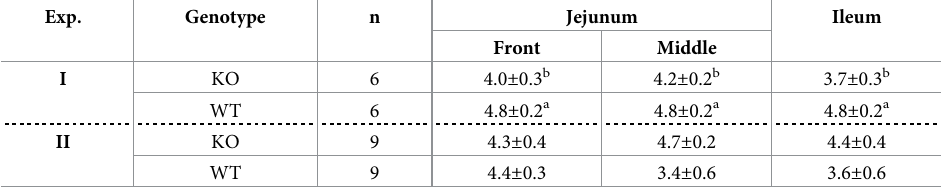
KO = CMAH KO homozygotes, WT = wild-type piglets. a, b . In exp. I, means between the same columns differ significantly (p <